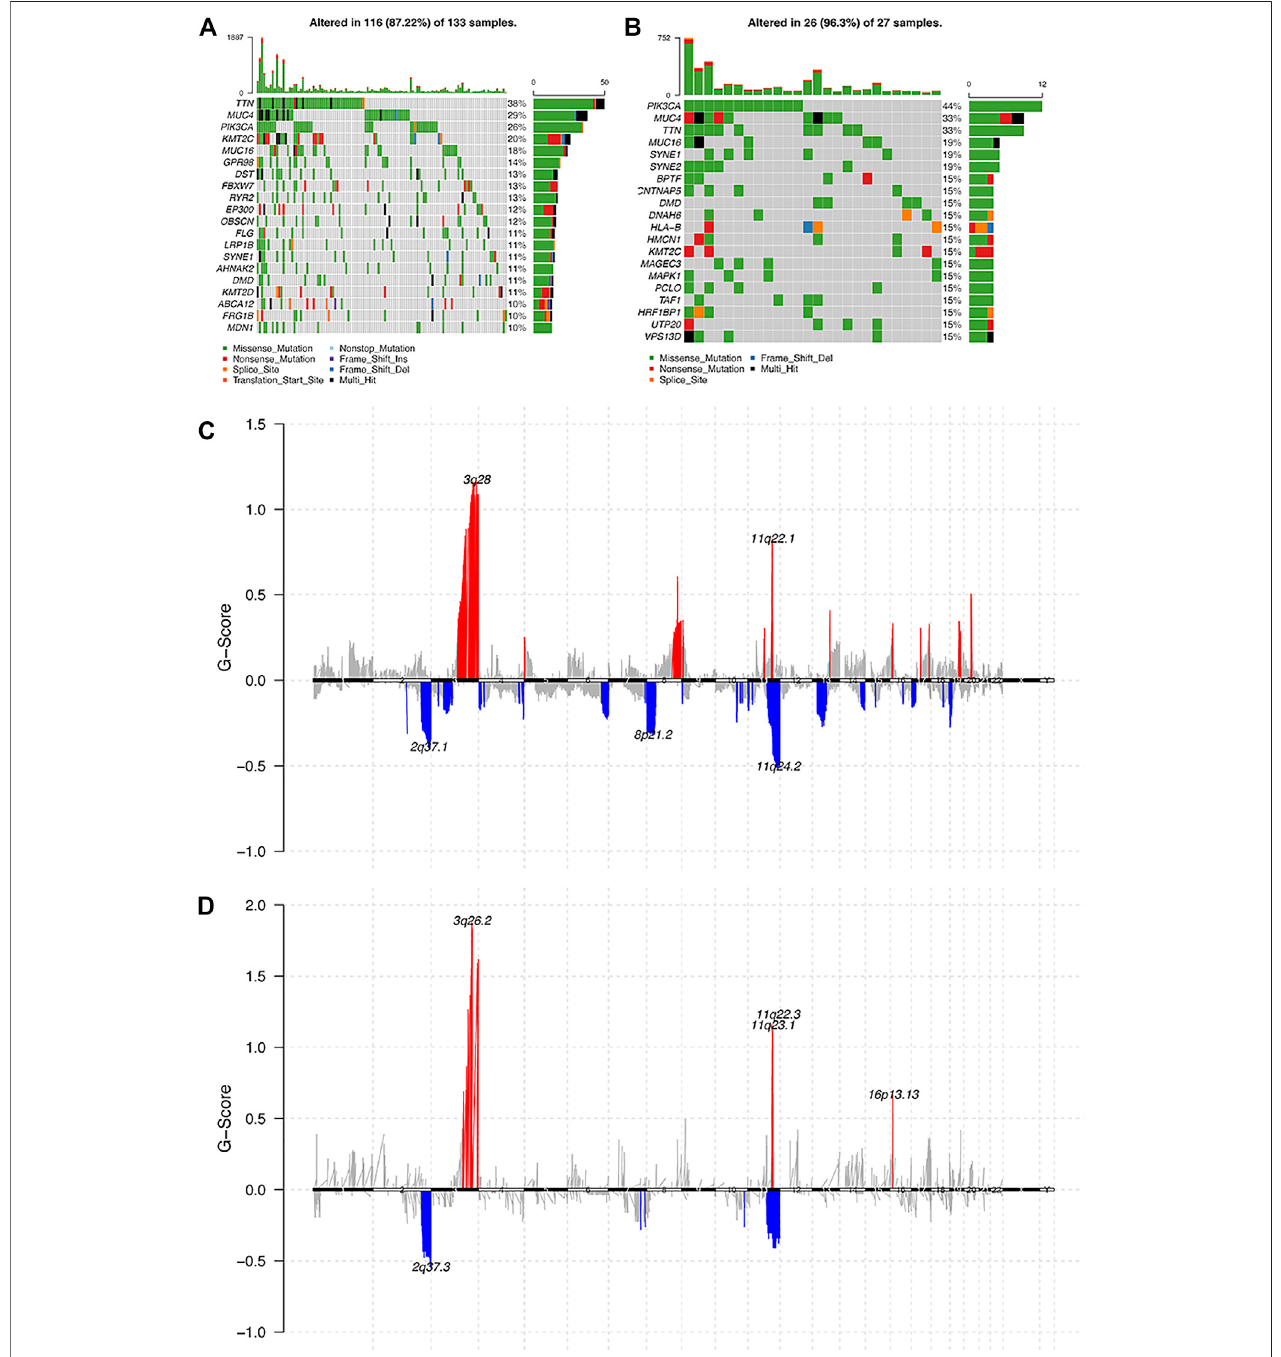
FIGURE 3 | Analysis of the molecular characters between pure HPV-infection and HPV-int samples. (A) : Gene mutation in pure HPV-infection samples, (B) : Gene mutation in HPV-int samples, (C) : Distribution of CNV regions among pure HPV-infection samples, (D) : Distribution of CNV regions among HPV-int samples.